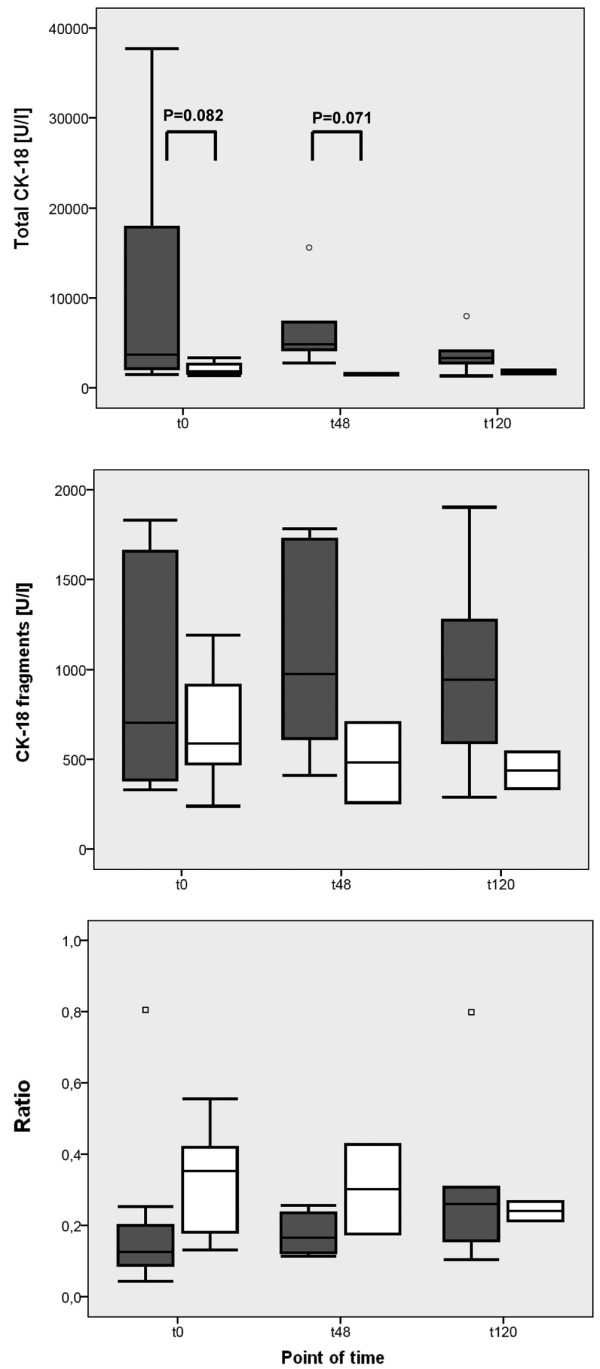
Comparison of cytokeratin measurements in survivors and non-survivors with impaired liver function in the septic group at baseline and at 48 and 120 hours. Concentrations were measured of total cytokeratin-18 (CK-18) and CK-18 fragments (CK-18-F), and the ratio of CK-18-F to total CK-18 was calculated from the sera of survivors (white box) and non-survivors (dark grey box) of the septic group with impaired liver function (bilirubin ≥1.2 mg/dL or 20.5 μmol/L according to Sequential Organ Failure Assessment (SOFA) score) at the time of diagnosis of sepsis (t0), and 48 hours (t48) and 120 hours (t120) later. Data in box plots are given as median, 25th percentile, 75th percentile and the 1.5 interquartile range. Outliers are shown in form of circles (1.5 to 3 interquartile ranges above 75th percentile or below 25th percentile) or rectangles (>3 interquartile ranges above 75th percentile or below 25th percentile).